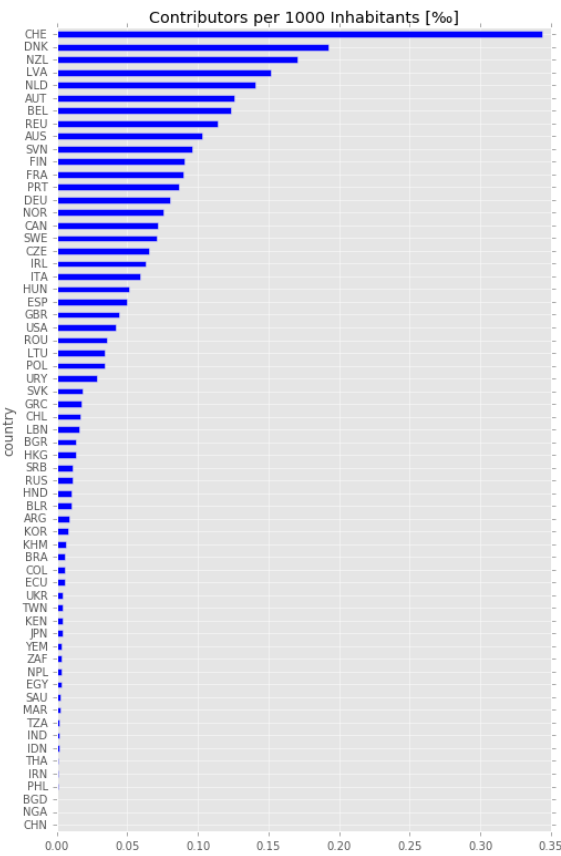
Figure 5. Share of geocoded unique contributors out of every 1000 country inhabitants [‰] (country code: ISO alpha-3)